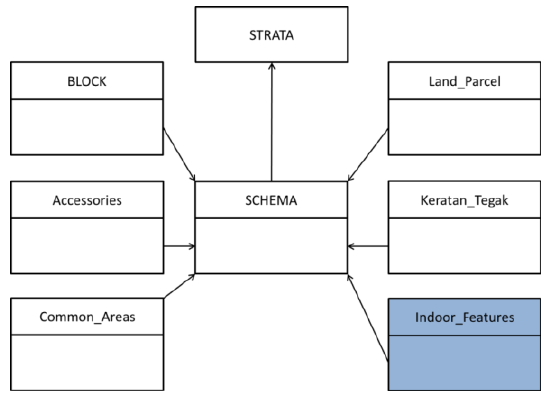
Figure 7. Schema structured integrated XML-IndoorGML